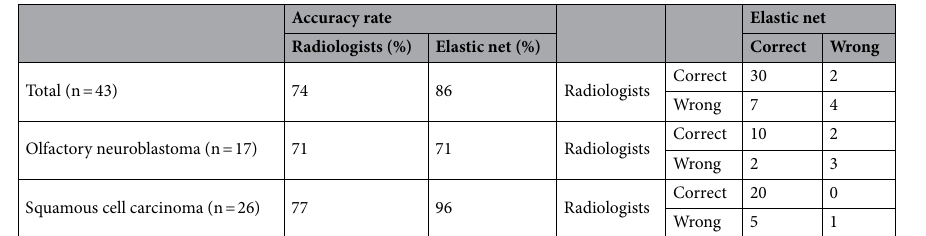
Table 3. Detailed accuracy of the elastic net model and radiologists’